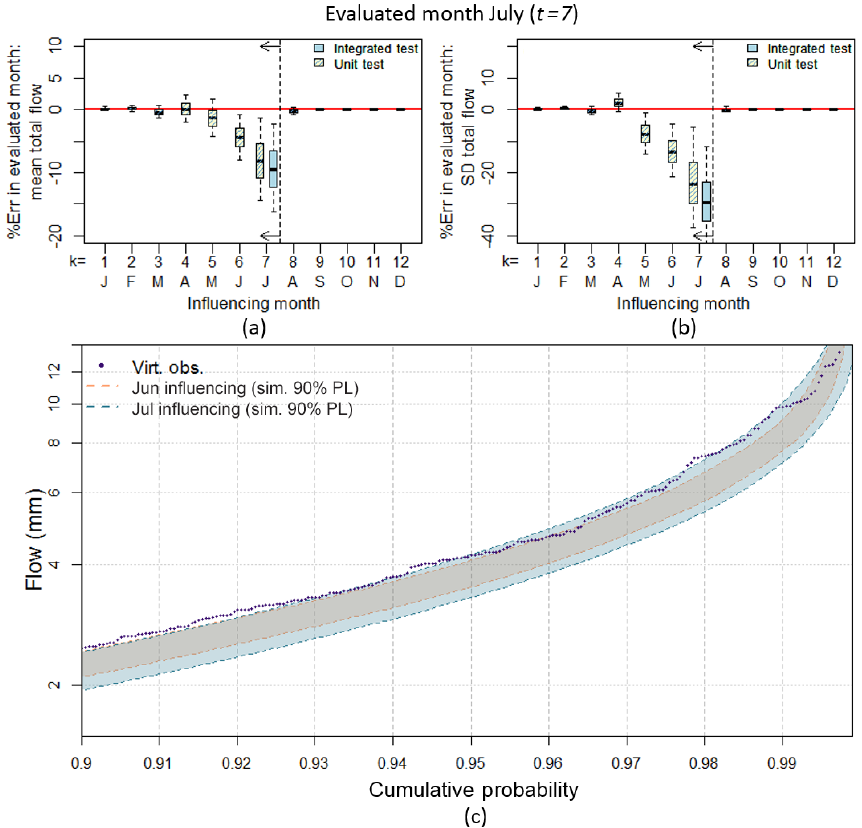
Figure 10. Lobethal, Site 12 (a) unit test error in mean monthly total flow (July), and (b) unit test error in standard deviation of monthly total flow (July), (c) July flow duration curve when June and July are selected as influencing months in unit test (top 10% of flow days shown). Boxplot whiskers indicate the 90% limits of the simulated streamflow replicates.